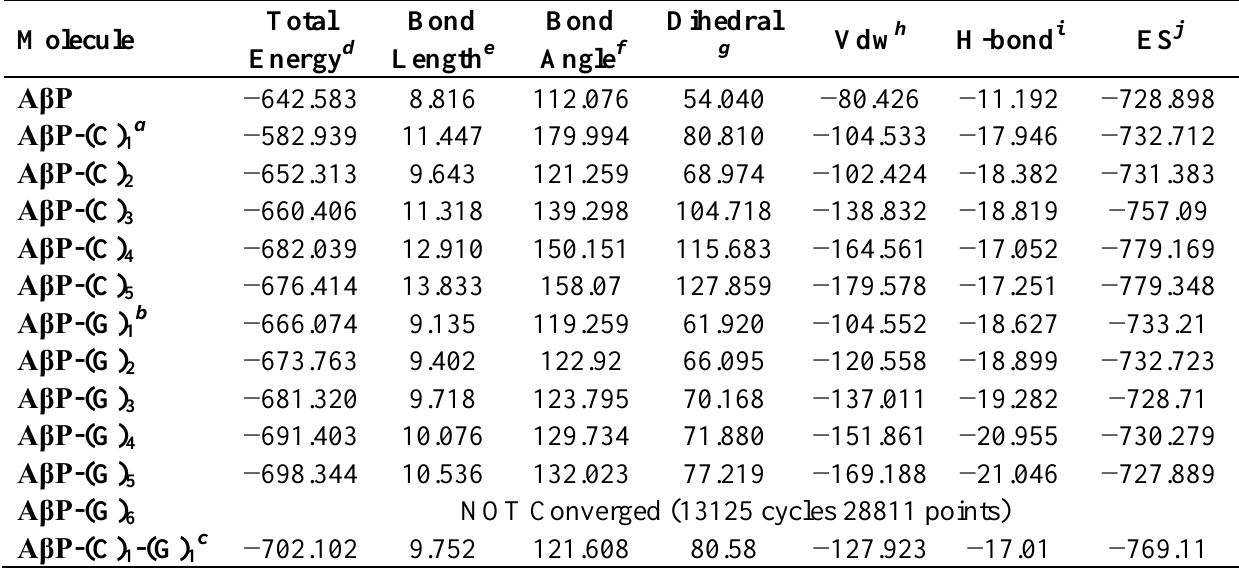
Table 6. Computed energy parameters (kcal/mol) of the protein-NE